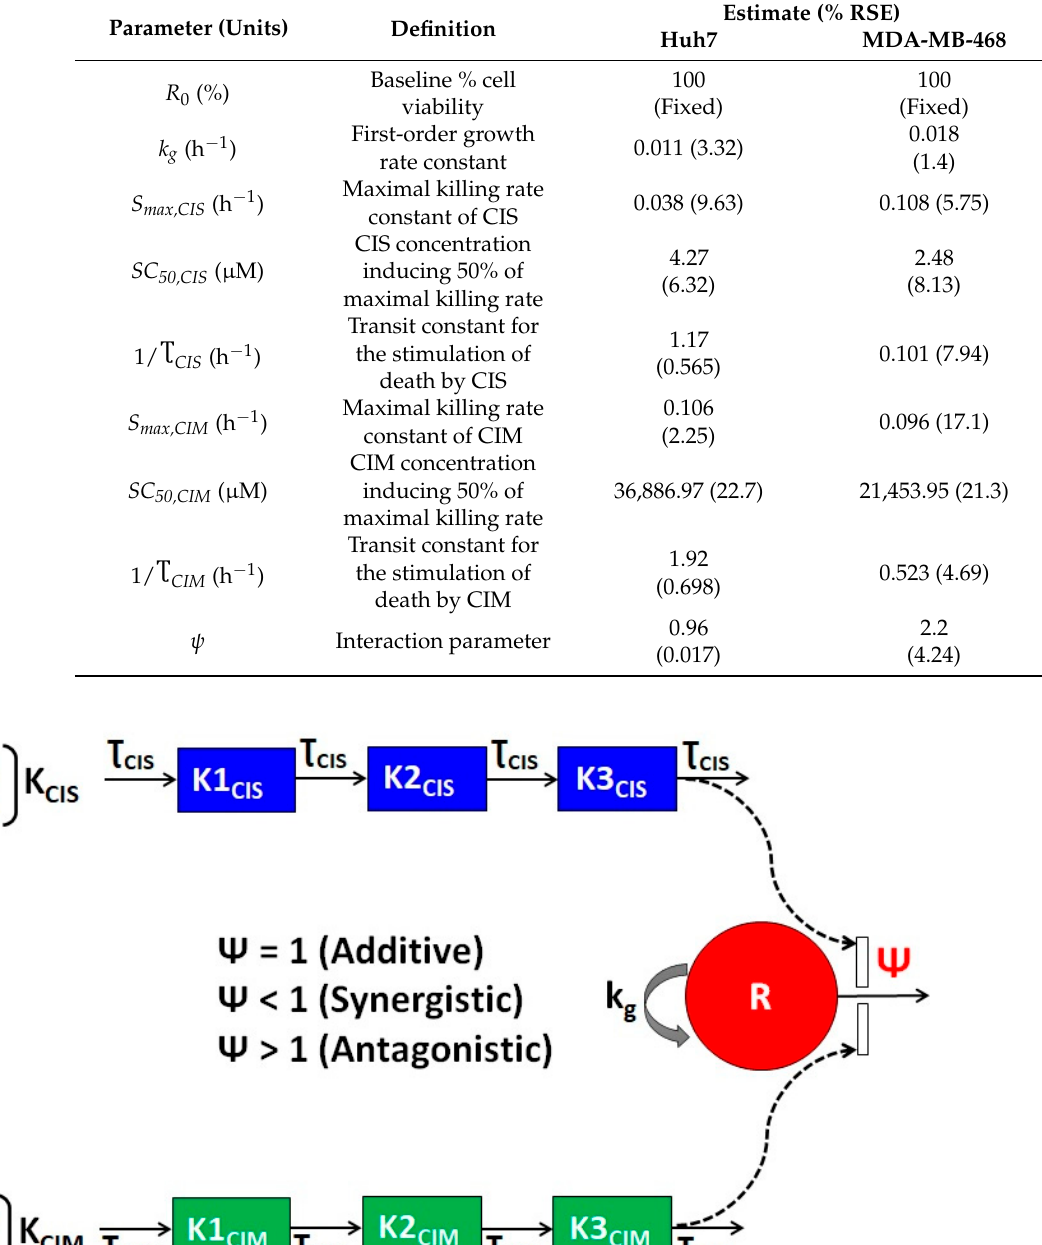
Table 2. Parameter estimates for the in vitro cellular-level pharmacodynamic model (PD) for the single and combinatorial effects of CIS and CIM on Huh7 and MDA-MB-468. % RSE = % relative standard error in the model parameters.